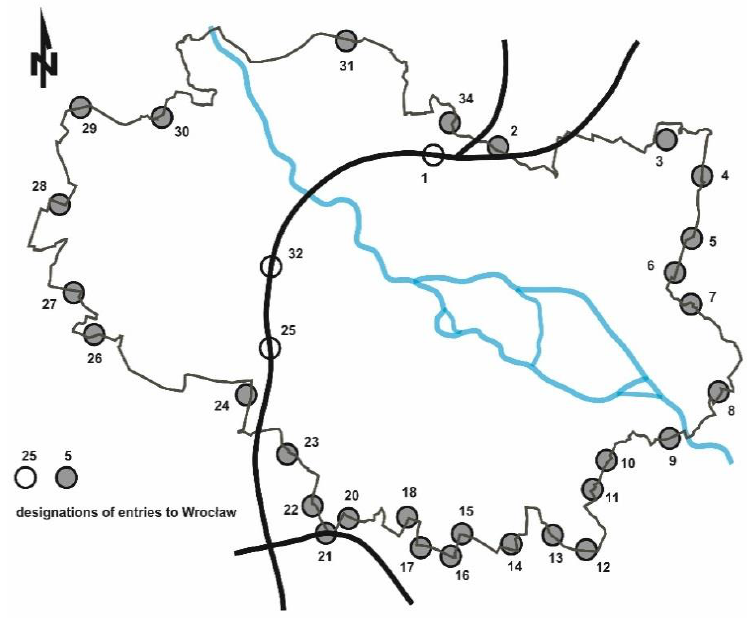
Figure 2. Location and numbering of inlets. Source: own research Table 2. Characteristics of inlets to the core (Wrocław) from a survey in the year